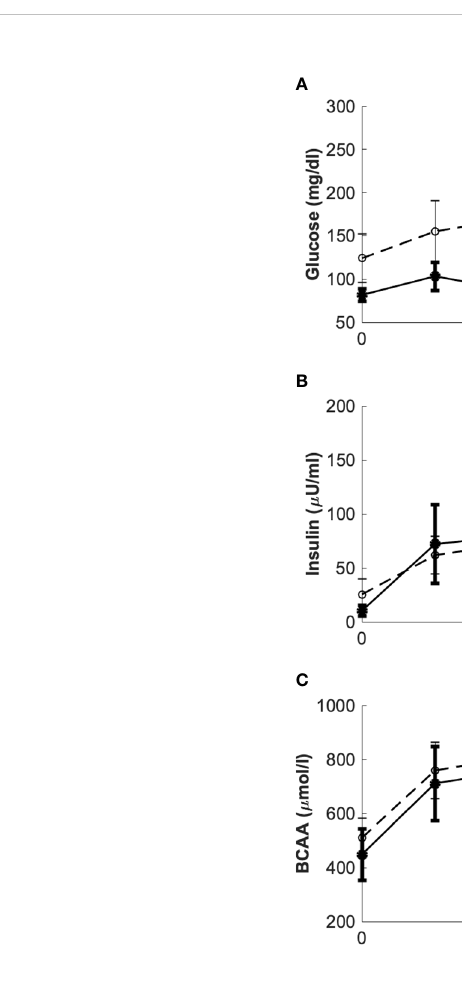
FIGURE 3 Glucose, insulin and BCAA curves from the reference mean experimental data by Karusheva et al. (7) (panels A – C , respectively), for glucose- tolerant participants (CNT, n=10, solid line) and patients affected by type 2 diabetes (T2D, n=10, dashed line). Closed and open circles (for CNT and T2D, respectively) indicate the time instants when the experimental samples were collected. Data are reported as mean ±